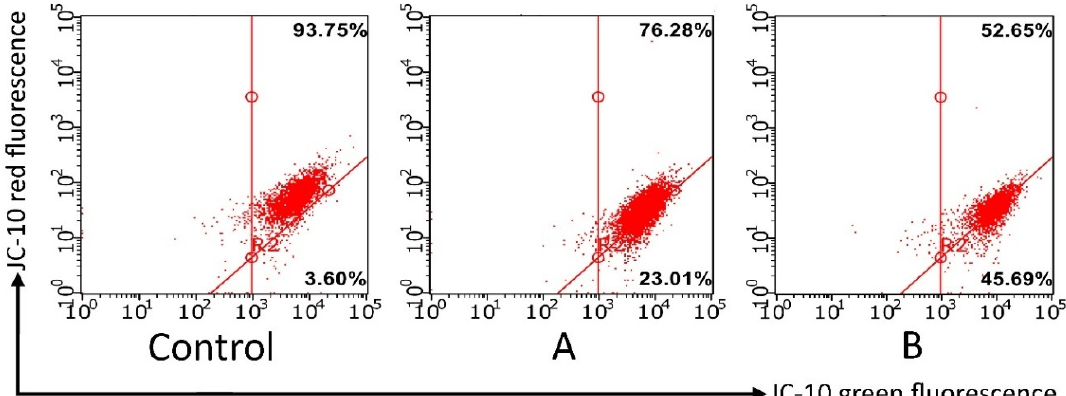
Figure 8. Flow cytometry analysis of M-HeLa cells treated with Compound 3f , along with the quantification of % of cells with red and green aggregates. ( A ) M-HeLa cells were treated with the indicated compound 3f at a concentration of 50 µ M. ( B ) M-HeLa cells were treated with the indicated compound 3f at a concentration of 100 µ M. The values are presented as mean ± SD.